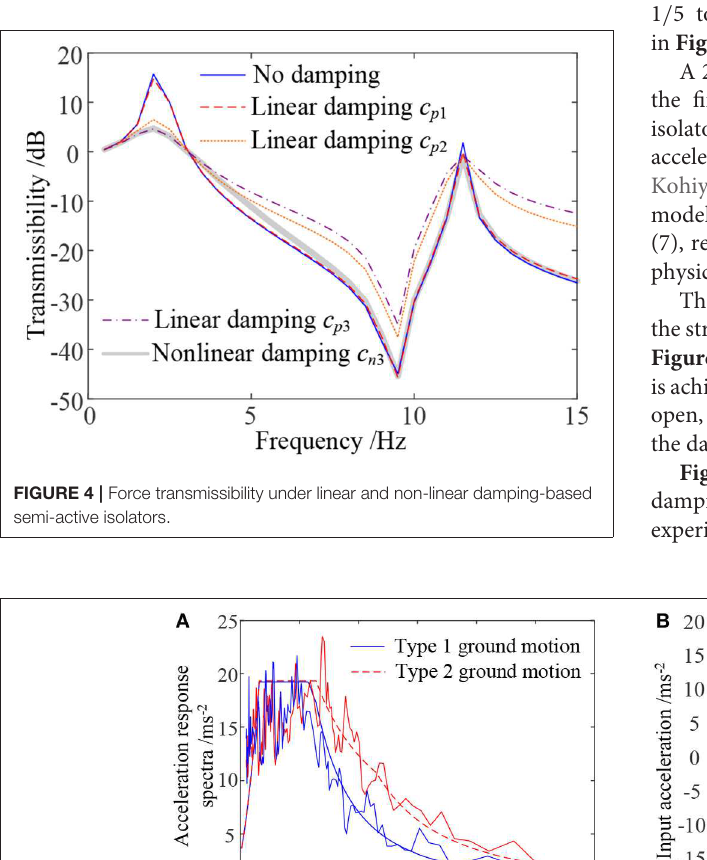
Frontiers in Built Environment |